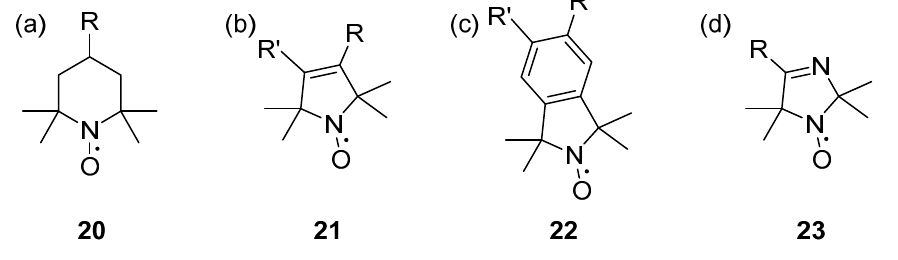
Figure 3. Parent structures of nitroxides; ( a ) a piperidine, ( b ) a pyrroline, ( c ) an isoindoline, ( d ) an imidazoline.